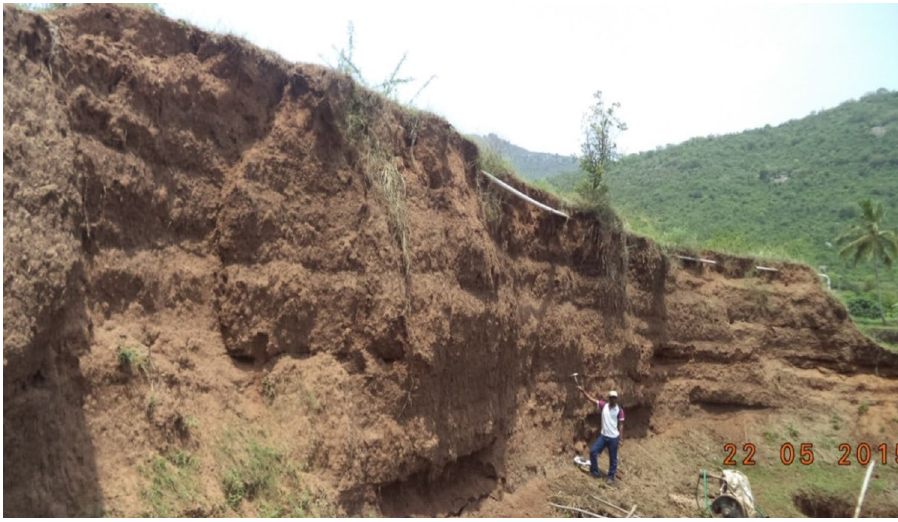
Fig. 12 Field photographs showing sediment silt (15 m) deposited at the nonanganur